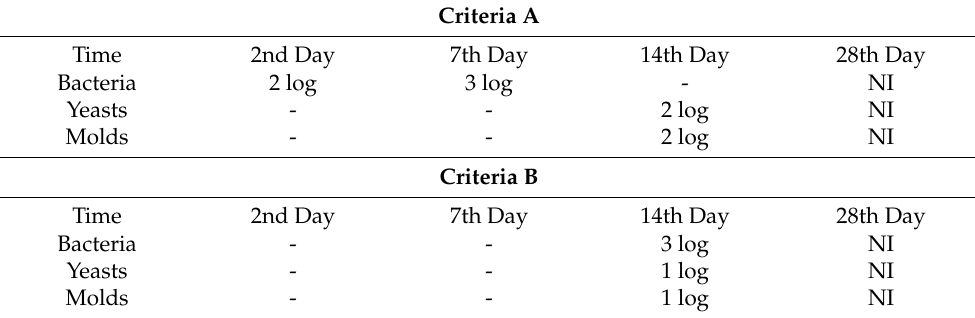
Table 4. European Pharmacopoeia, Criteria A and B, for cutaneous application, minimum reduction in log